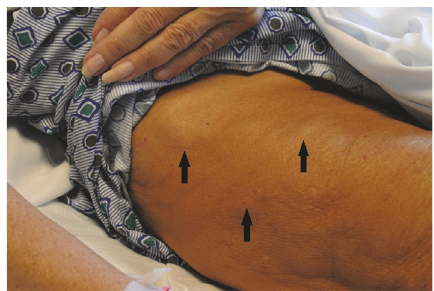
Figure 2: Palpable nodules (arrows) over the right thigh.